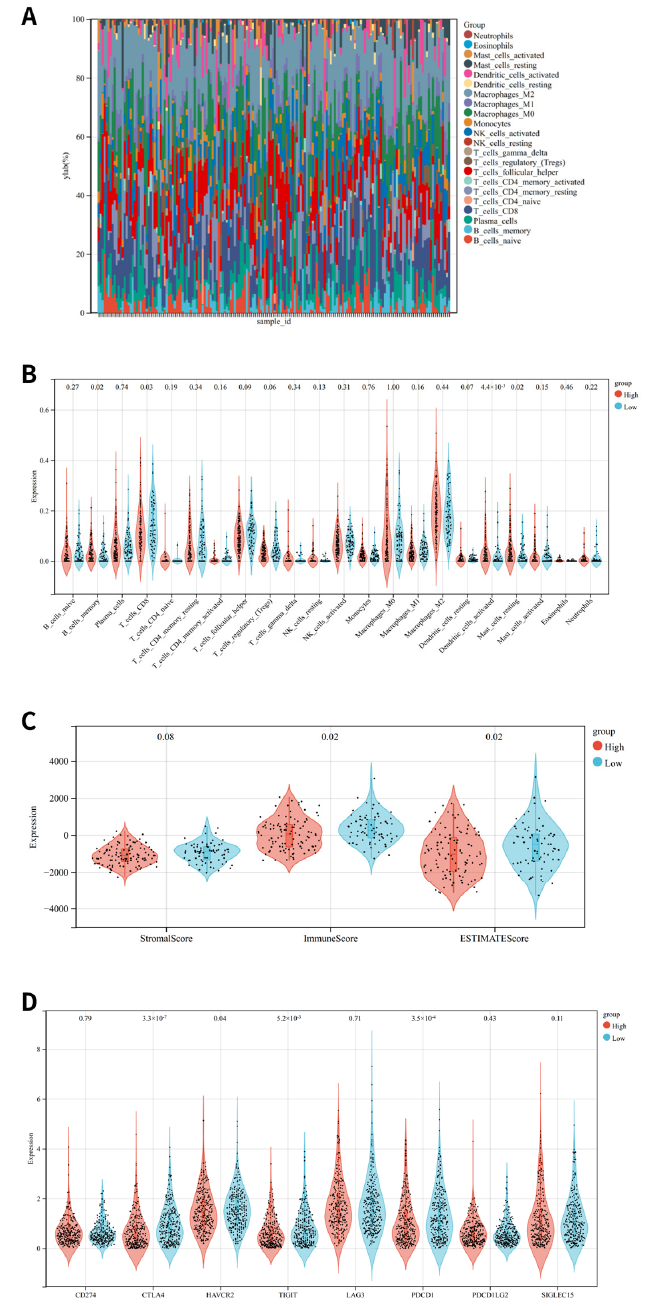
Figure 7. The immune landscape of risk-high and low subtypes: ( A ) Relative proportion of immune infiltration in TCGA samples; ( B ) Violin plot visualizes significantly different immune cells between different subtypes; ( C ) Violin plots show the stromal score, immune score and ESTIMATE score; ( D ) Violin plot present differential expression of multiple immune